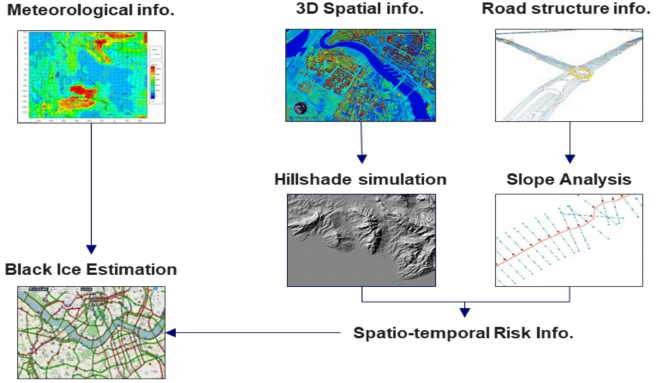
Figure 1. The overall concept of the proposed black ice risk estimation